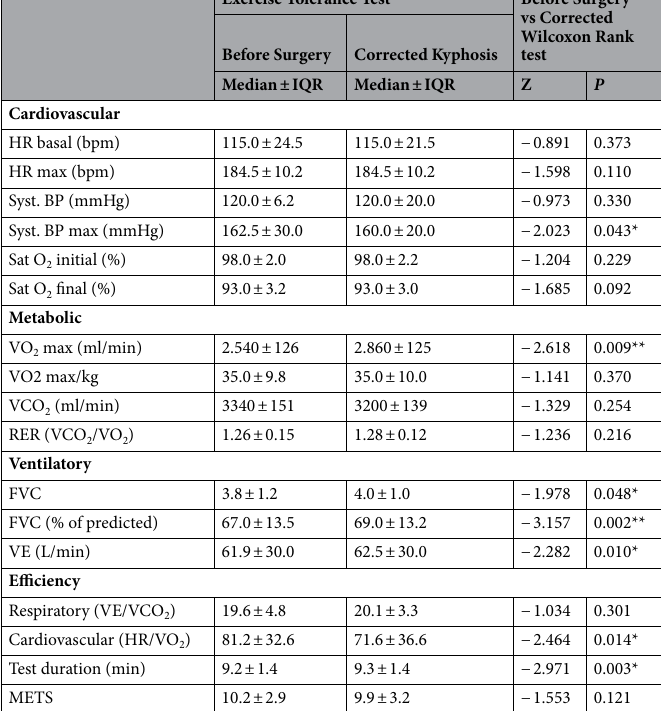
vs Corrected Wilcoxon Rank